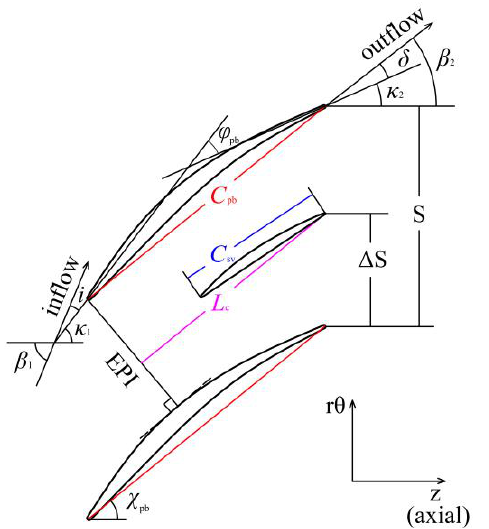
Figure 3. Geometry definitions of splittered compressor cascades.